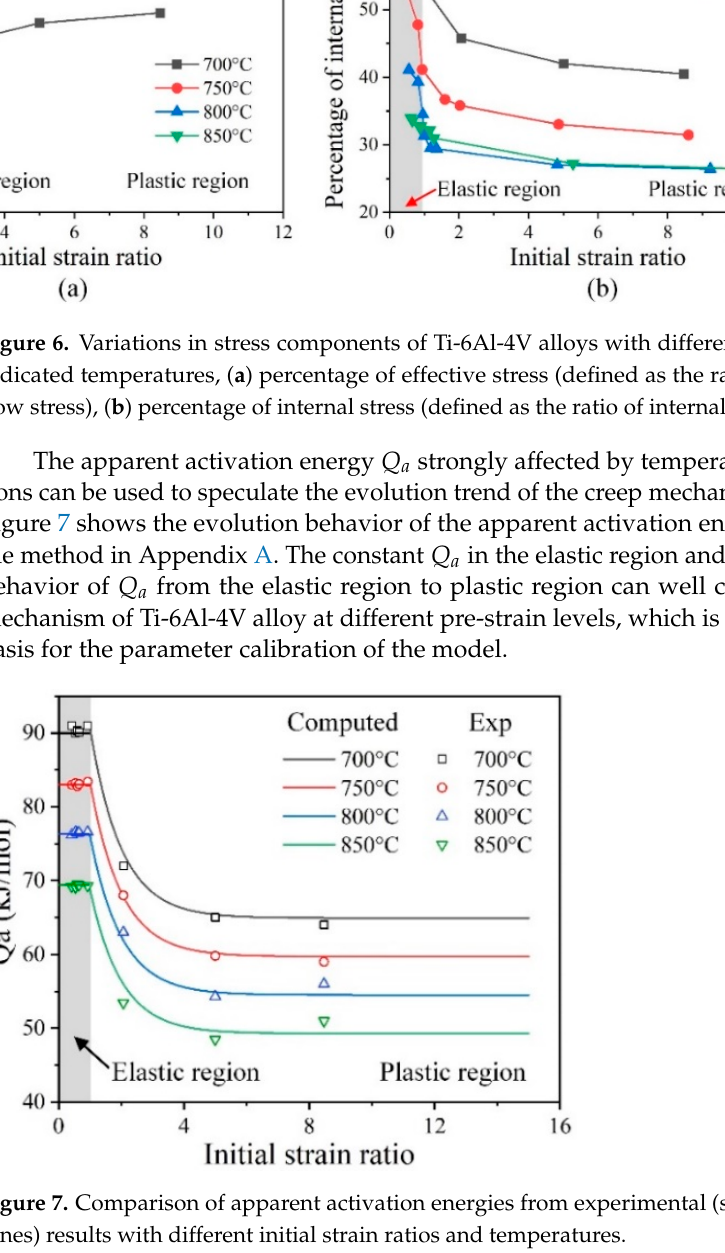
Figure 7. Comparison of apparent activation energies from experimental (symbols) and computed (lines) results with different initial strain ratios and temperatures.